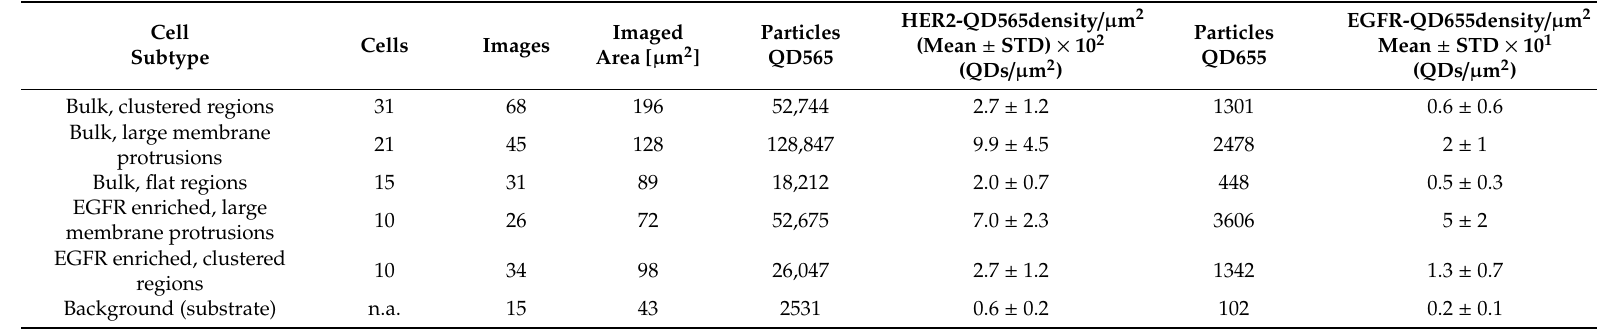
Table 1. STEM statistics for dually labeled and analyzed SKBR3 cells and images. For each cell type (bulk or EGFR enriched) and region (LMP, clustered or flat), the number of analyzed cells, images, particles (QD565 and QD655) and the calculated densities for QD-labeled HER2 and EGFR is given. n.a. not applicable. See Supplemental Table S1 and [46] for errors of QD